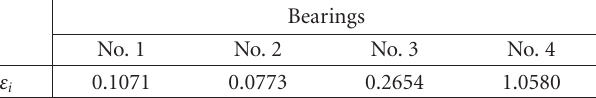
Table 4: Residuals provided by the fault identification